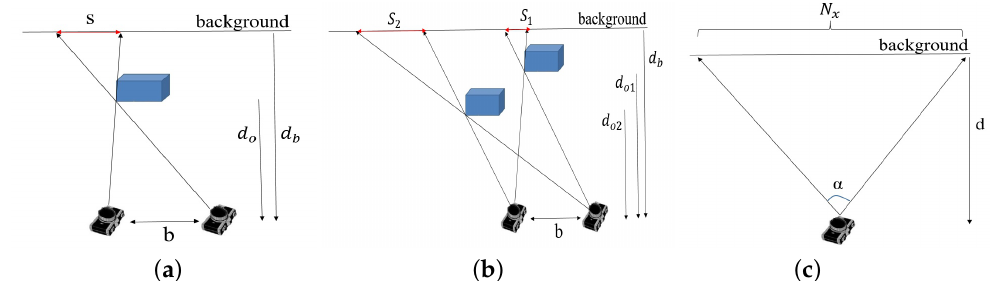
Figure 16. ( a ) A shadow in a depth image is the area observed by the left camera component (e.g., IR sensor) while blocked from view of the right component (e.g., IR projector). ( b ) Shadow size ( S 1, S 2) depends on object distance from camera. ( c ) Conversion from world units to image units.